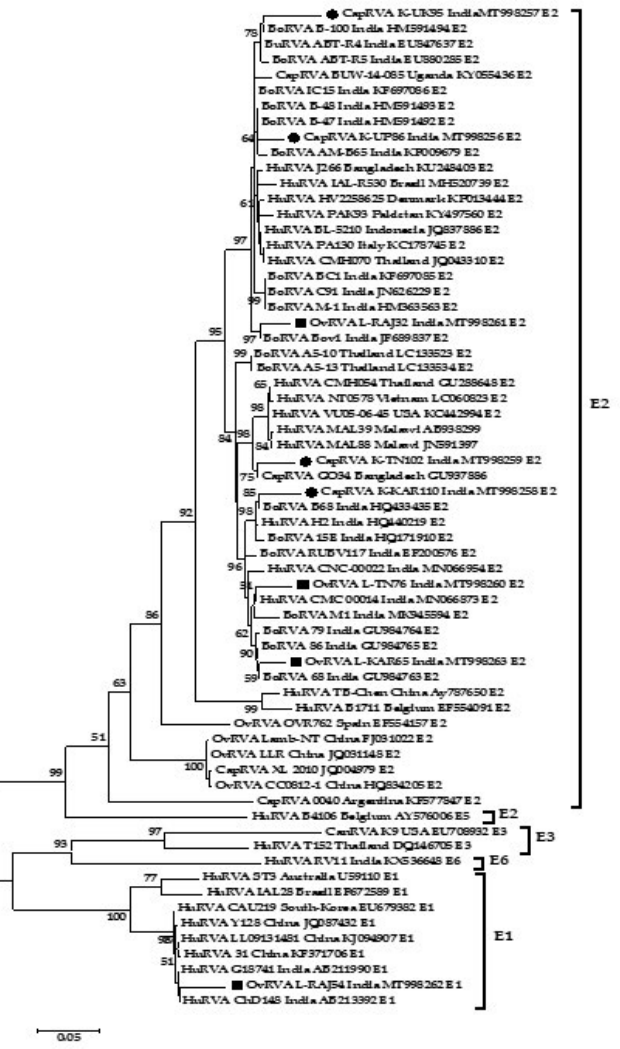
Fig. 1: Phylogenetic analysis of small ruminant RVA based on the full-length NSP4 gene. Caprine and ovine strains have been depicted with a black circle (●) and black square ( ■ ) respectively. The tree is divided into E2 major and an E1 minor clade which comprises current study